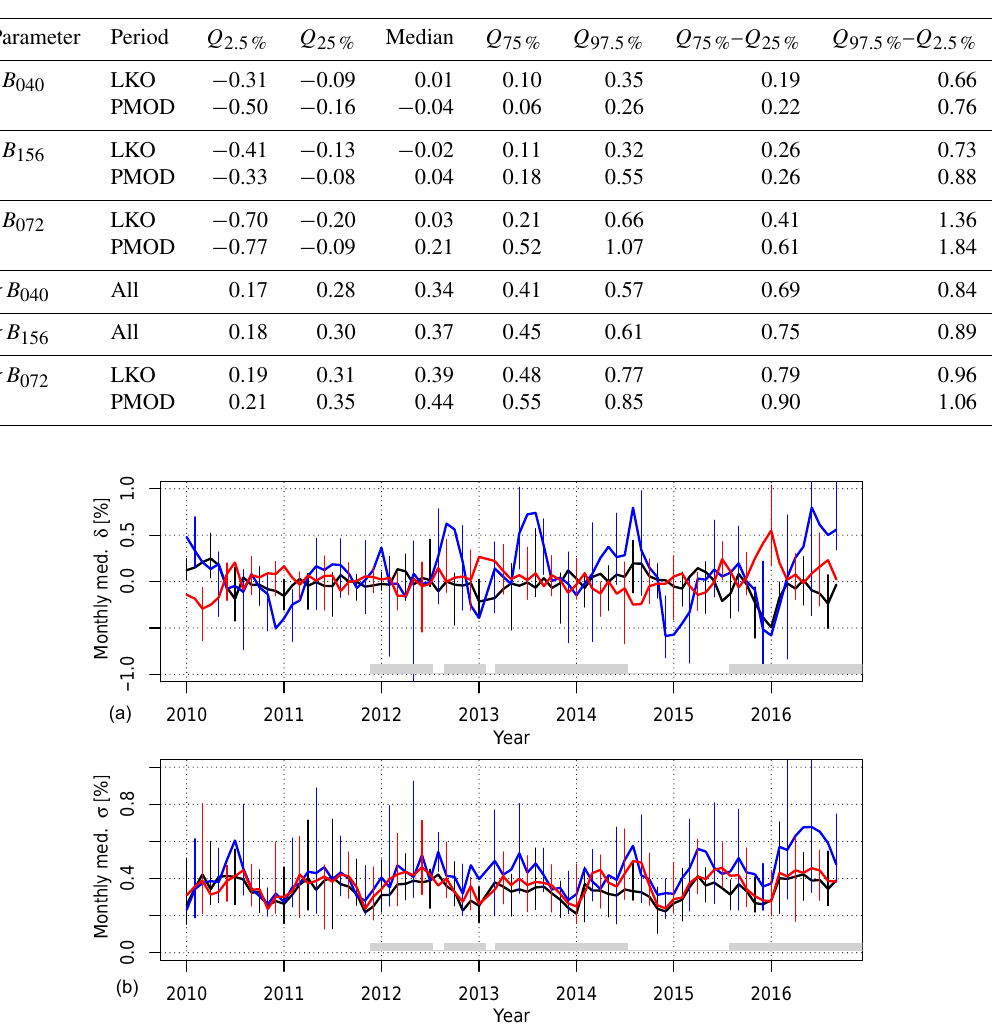
Table 3. Quantiles of the distribution of the parameters δ and σ of the three Brewer instruments expressed in [%]. Under the “period” column, LKO means that the B 072 instrument was collocated at Arosa, PMOD corresponds to having B 072 at Davos and “all” is for the whole period. The sample sizes were 705 days for the Arosa period and 801 days for the Davos period.